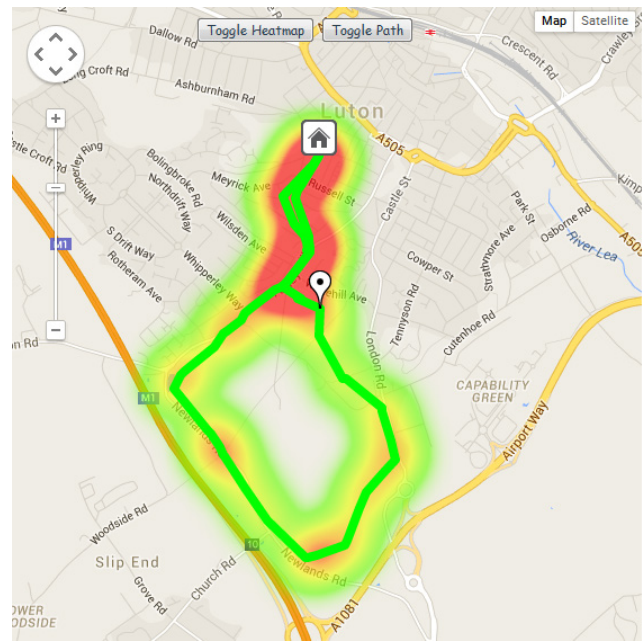
Figure 6 Map visualisation of routes and locations of daily activities from Moves